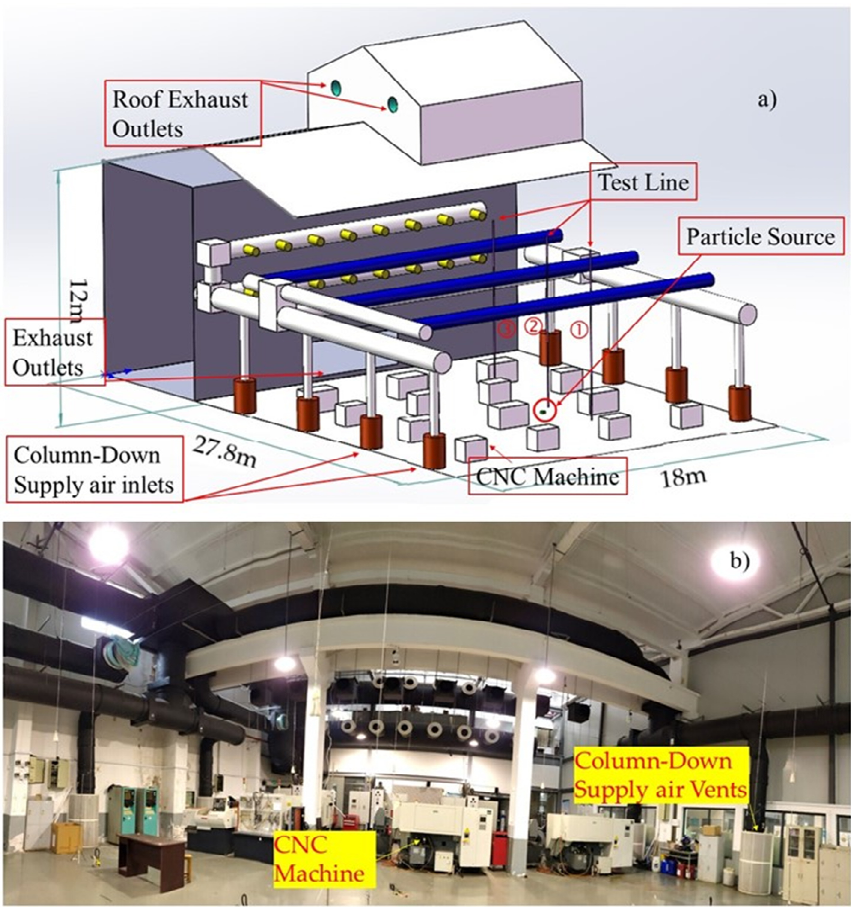
Figure 2. Experimental facility and ventilation system for CFD validation: ( a ) Diagram of experimental facility, and ( b ) picture of experimental indoor scene.